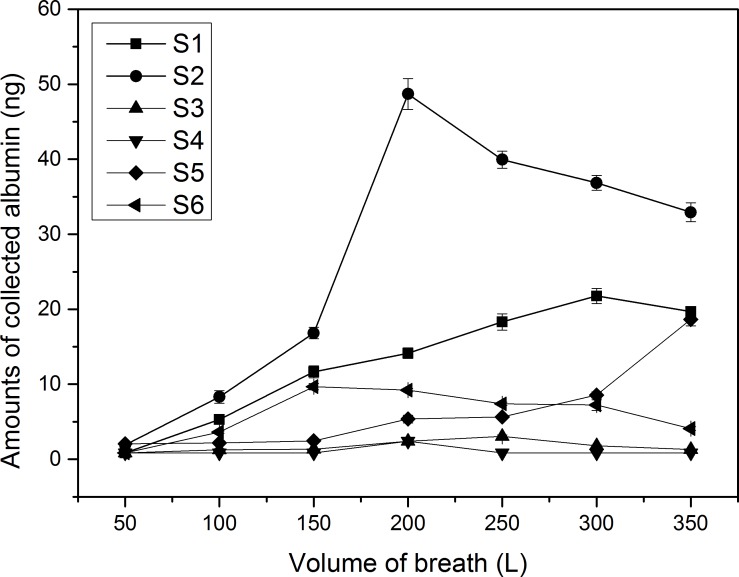
Amounts of albumin in human exhaled breath collected using self-designed collecting devices.The amounts of collected albumin were calculated by Eq 2. Error bars shown in the figure were standard deviation of triplicate measurements of each sample.